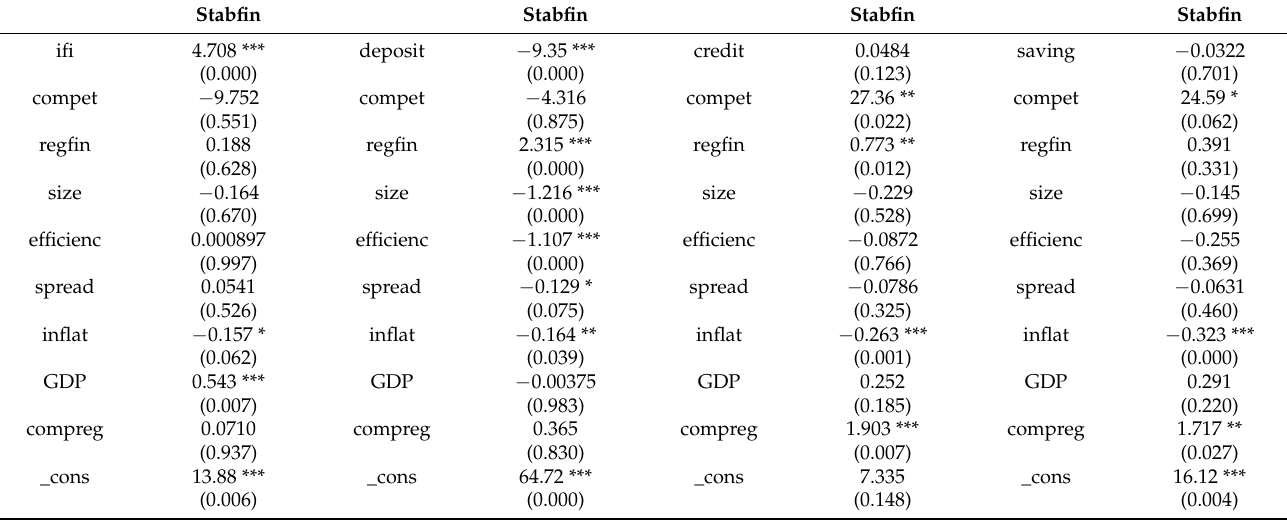
Table 11. The moderating role of financial regulation in LAC